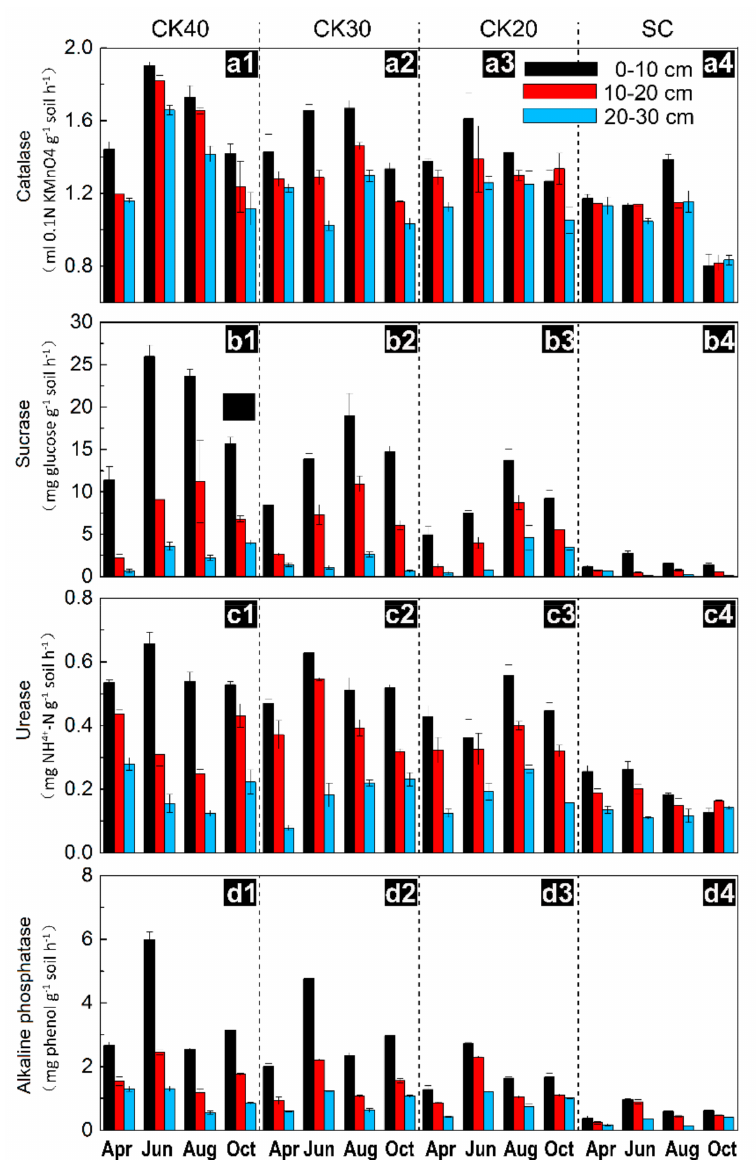
Figure 3. Soil enzyme activities (catalase, a1–a4; sucrase, b1–b4; urease, c1–c4; and alkaline phosphatase, d1–d4) in di ff erent soil layers (0–10, 10–20, and 20–30 cm) under di ff erent land-use types in four months. Each bar has nine replicates (three sample lands × three replicate plots). The error bar is the standard error. CK40, CK30, CK20, and SC represent 40-, 30-, and 20-year-old Caragana korshinskii Kom. lands and slope cropland, respectively. The detailed ANOVA results of the significant e ff ects of the di ff erent treatments on the soil properties are shown in Table